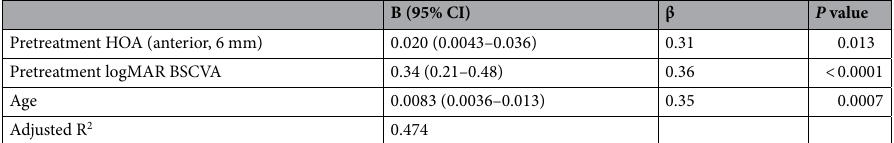
Table 6. Multivariable analysis to identify pretreatment clinical factors associated with posttreatment visual acuity. One patient each with proliferative diabetic retinopathy, advanced glaucoma, and moderate-to-severe cataract were excluded from the analysis of visual acuity. BSCVA best spectacle-corrected visual acuity, HOA higher-order aberration, logMAR logarithm of the minimum angle of resolution, B partial regression coefficient, CI confidence interval, β standardised partial regression coefficient, R 2 coefficient of